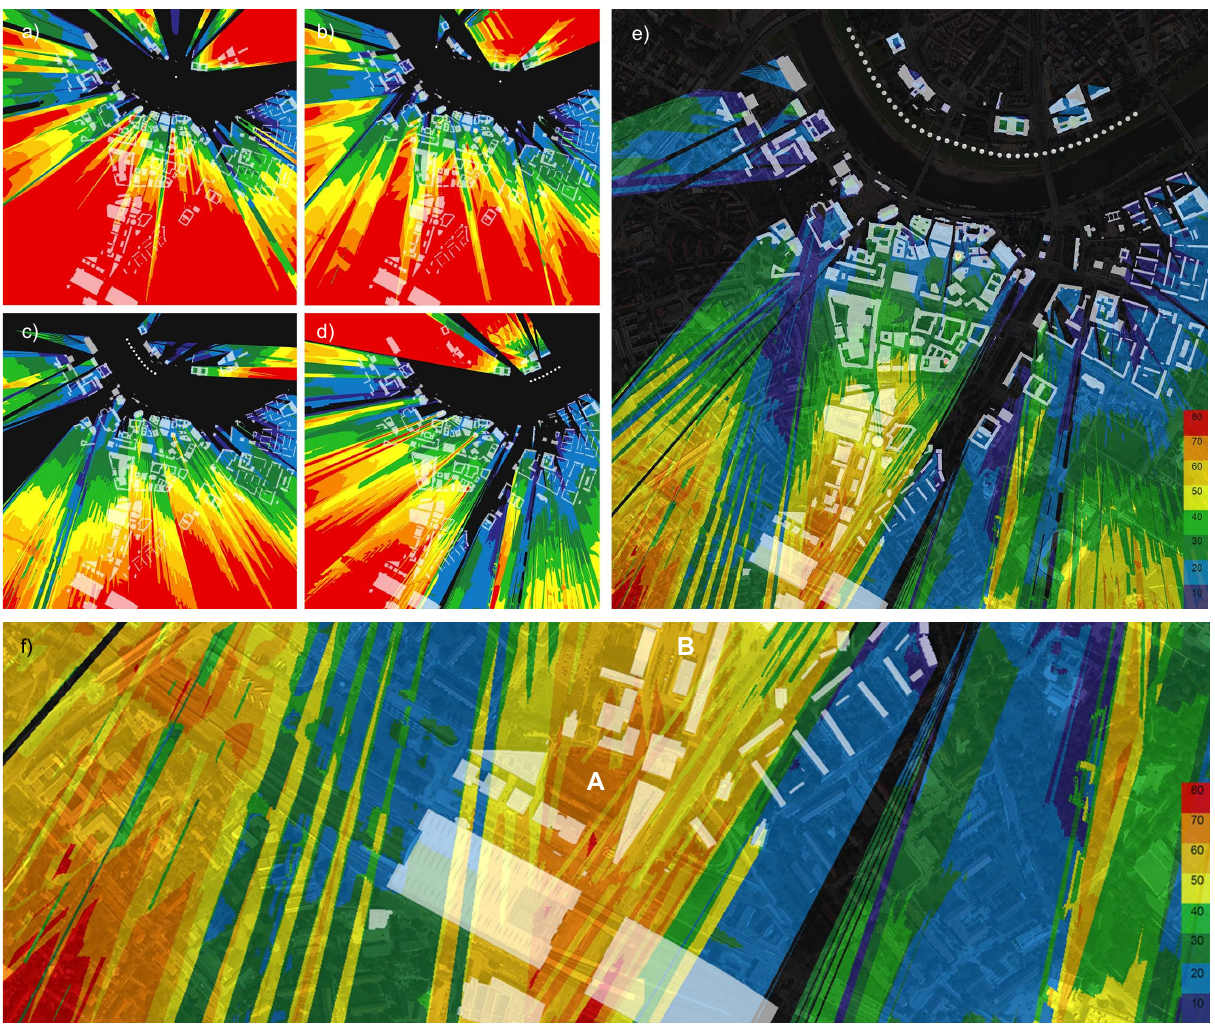
Figure 9. Comparison of simulations using VPS method for view points situated along river: a) simulation for one point; b) simulation for two points; c) simulation for 11 points situated extremely westward; d) simulation for 8 points situated extremely eastward; e) simulation for 40 points; f) zoom in for a part of simulation for 40 points with area of highest possible development